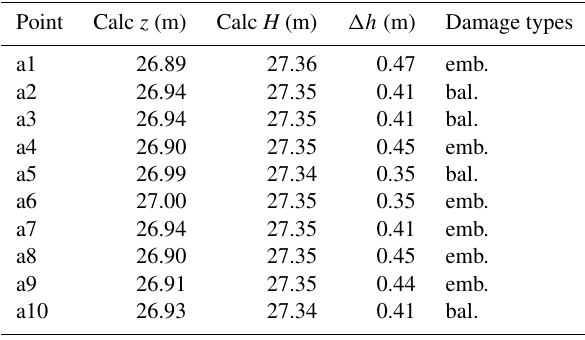
Table A1. Point-wise estimated overtopping water depth (cid:49)h and damage types for the Asa River flood. In damage types row, emb. is embankment scour, bal. is ballast scour, and no is no damage. Location of each point is indicated in Fig. 14.